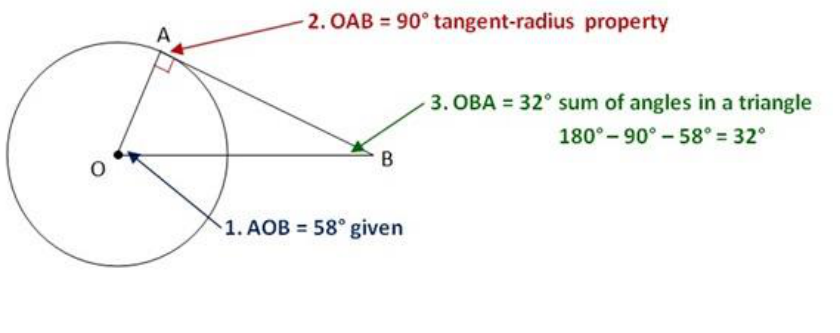
Figure 1. A sample worked